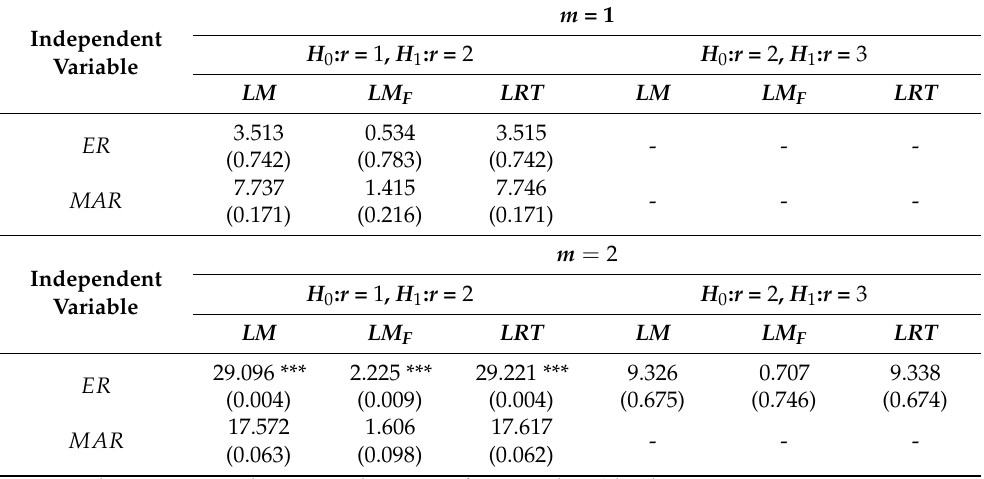
Table 3. Remaining non-linearity test results.